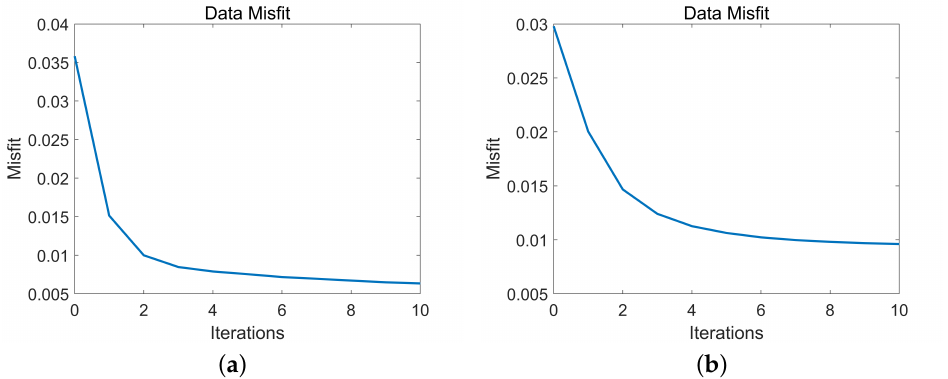
Figure 6. Reconstruction data misfit: ( a ) 433 MHz; ( b ) 915